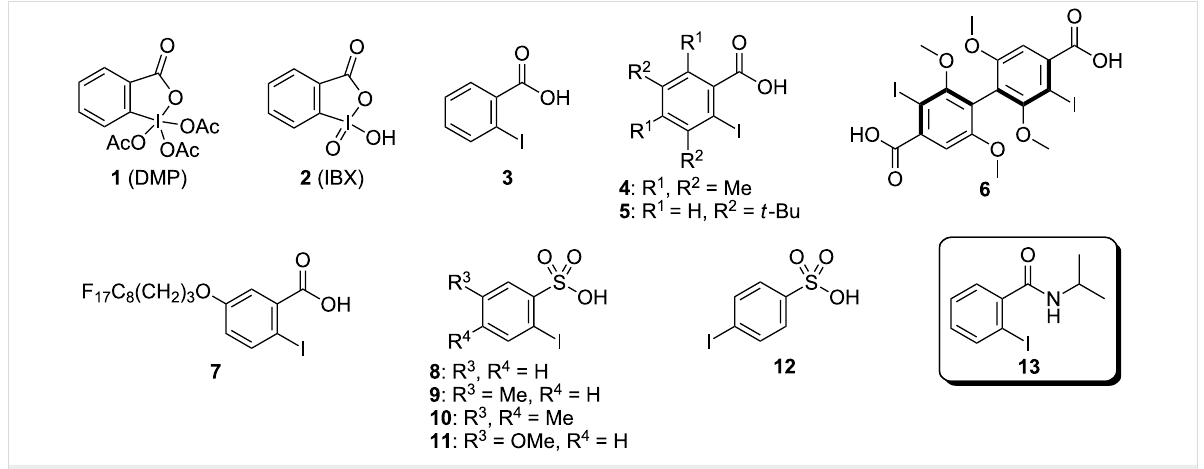
Figure 1: Structures of pentavalent iodine oxidants 1 and 2 , and iodine catalysts 3 – 13